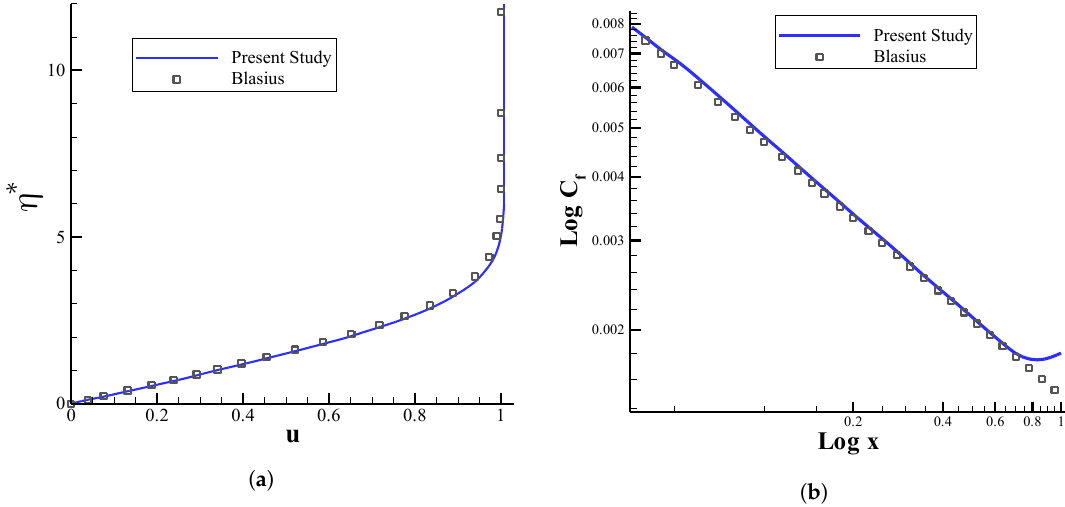
Figure 1. Profiles of ( a ) horizontal velocity and ( b ) skin friction coefficient for flow over a flat plate with Ma = 0.2 and Re = 200 × 10 3 . The results obtained from the Blasius boundary layer solution is also indicated by solid squares for comparison